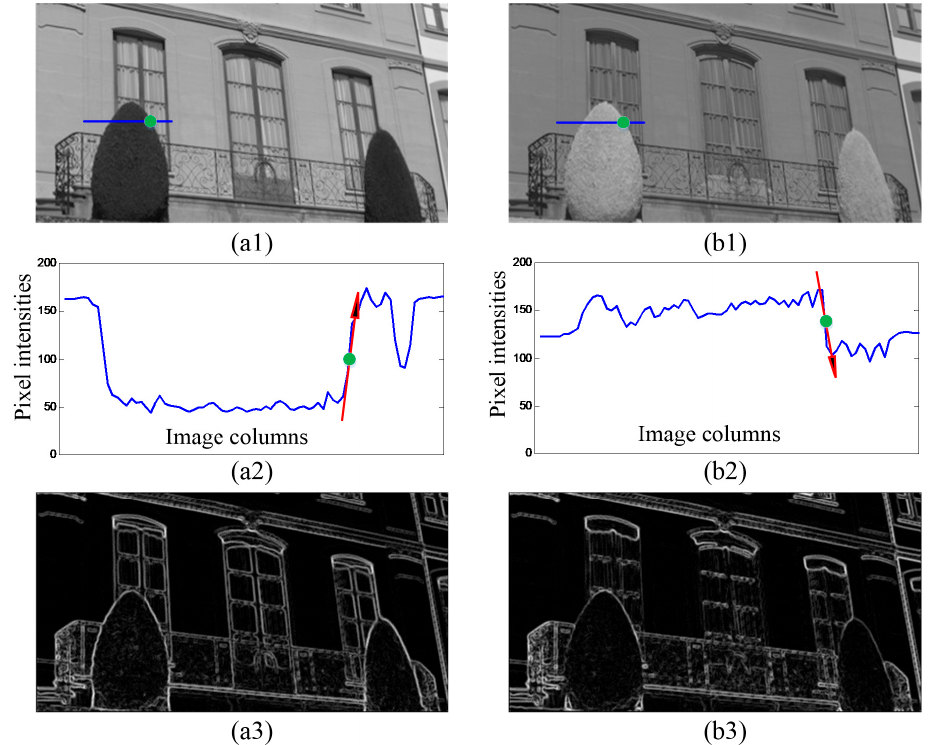
Figure 1. Gradient direction variations and structure guidance images between multispectral images ( a ) visible image, and ( b ) infrared image. From top to bottom: (1) source images, (2) gradient directions, and (3) structure guidance images. The green dot indicates the position of the interest point.